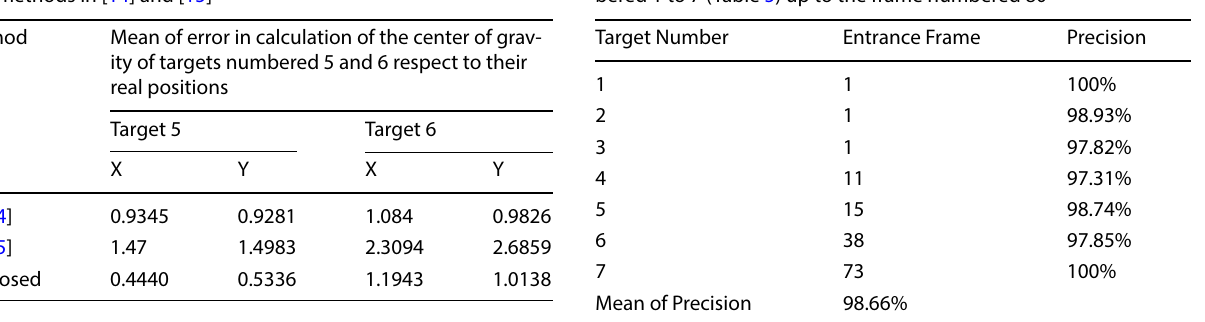
Table 9 Performance precision of the proposed method using S2.L1 scenario of PETs2009 database for tracking of targets